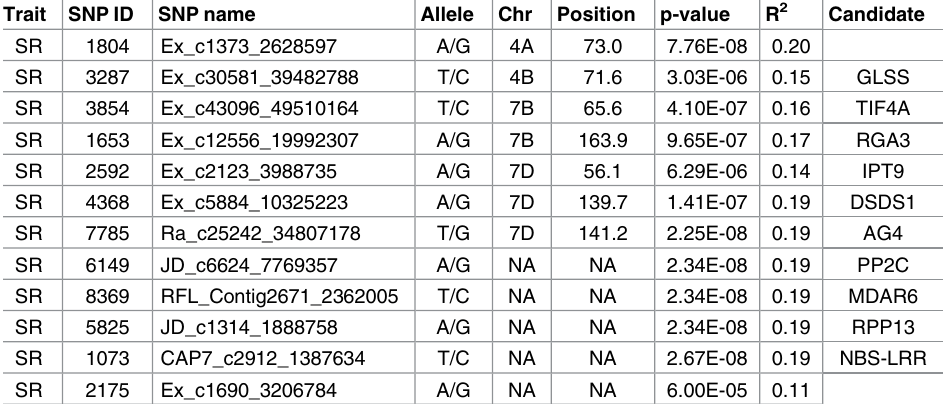
Table 2. Most significant SNP markersassociated with stem rust resistance in the 5 th SRRSN wheat lines. Trait SNP ID SNP